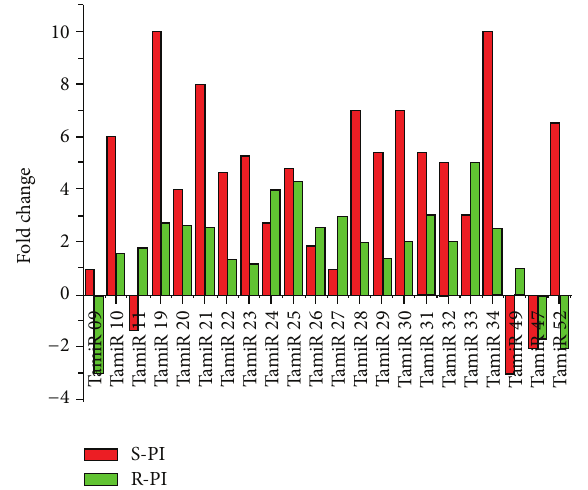
Figure 3: Comparative expression analysis of differentially expressed miRNAs in wheat NILs in response to leaf rust pathogen.